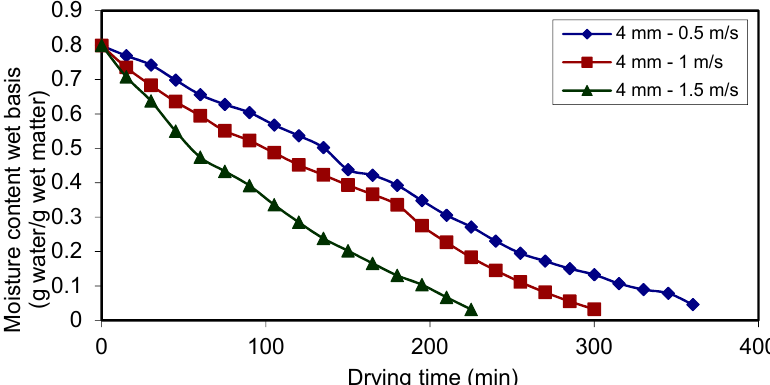
Figure 3. Moisture content wet basis as a function of drying time for drying air velocity of 0.5, 1 and 1.5 m/s and slice thicknesses of 4 mm for kiwi fruits.